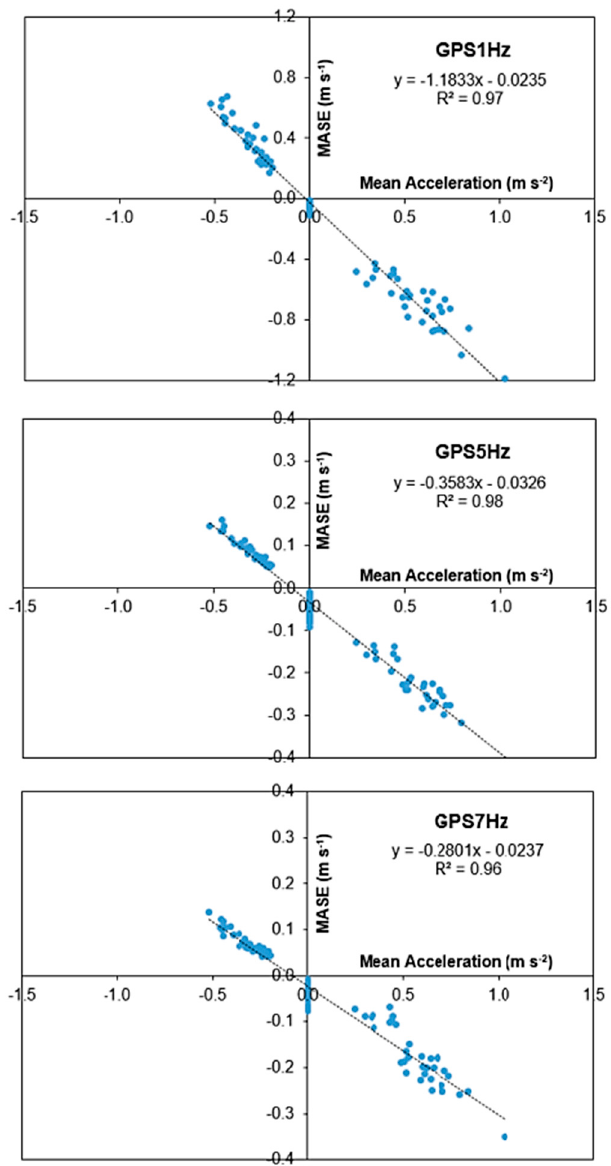
Figure 7. Relationship between the mean absolute speed errors (MASEs) and the mean acceleration levels for the three GPS speed sensors with different data update frequencies.